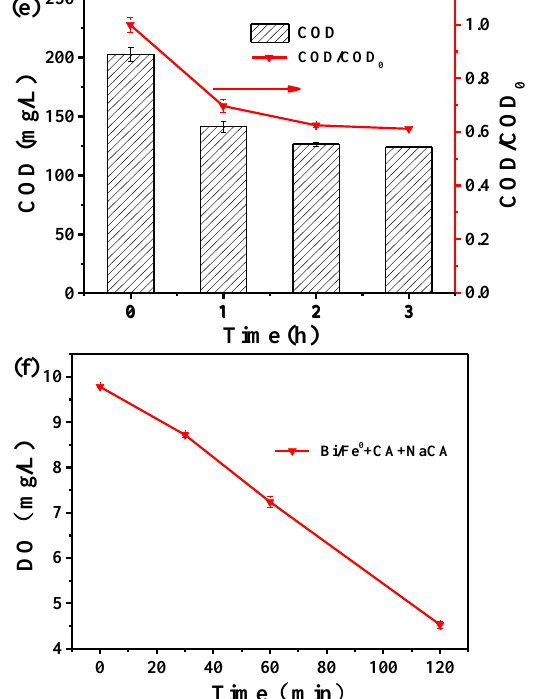
Figure 3. The degradation efficiencies of ( a ) SM2, ( b ) SMX, and ( c ) SD in different systems as a function of time; ( d ) The degradation efficiencies of mixed liquid in Bi/mZVI+CA+NaCA system; The variation of ( e ) COD and ( f ) DO trend of mixed liquid in Bi/mZVI+CA+NaCA system.